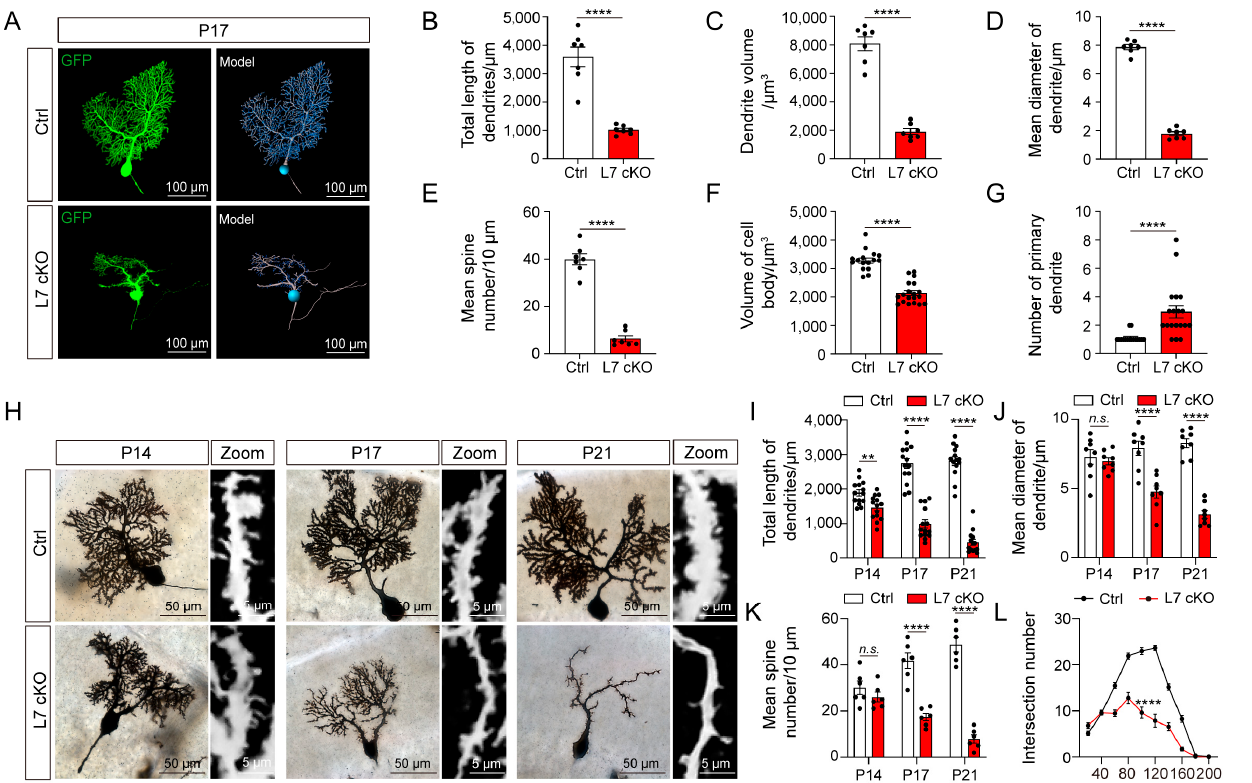
Figure 3. PCs were degenerated in the cKO mice. ( A ) The cerebella of the Ctrl and cKO mice were infected with a virus, and infected positive PCs exhibited by GFP (green) and the reconstruction of PCs using Imaris are shown (scale bar: 100 µm). (B-G) Morphometric analyses of the total length of dendrites ( B ), dendrite volume ( C ), dendrite mean diameter ( D ), spine density ( E ), volume of the cell body ( F ) and number of primary dendrites ( G ) of PCs (mean ± SEM; **** p < 0.0001, n > 5). ( H ) The morphology of the PCs after Golgi impregnation (scale bar: 50 µ m). A zoom showing a high-magnification picture of the PC dendrites (scale bar: 5 µ m). ( I – K ) Quantification of the total length of the dendrites ( I ), dendrite mean diameter ( J ) and spine density ( K ) (mean ± SEM; ** p < 0.01, **** p < 0.0001, n.s. = no significance, n > 5). ( L ) Sholl analysis of the intersection number of the dendrites at different distances from the cell body of the PCs in the Ctrl and cKO mice (mean ± SEM; **** p < 0.0001, n >